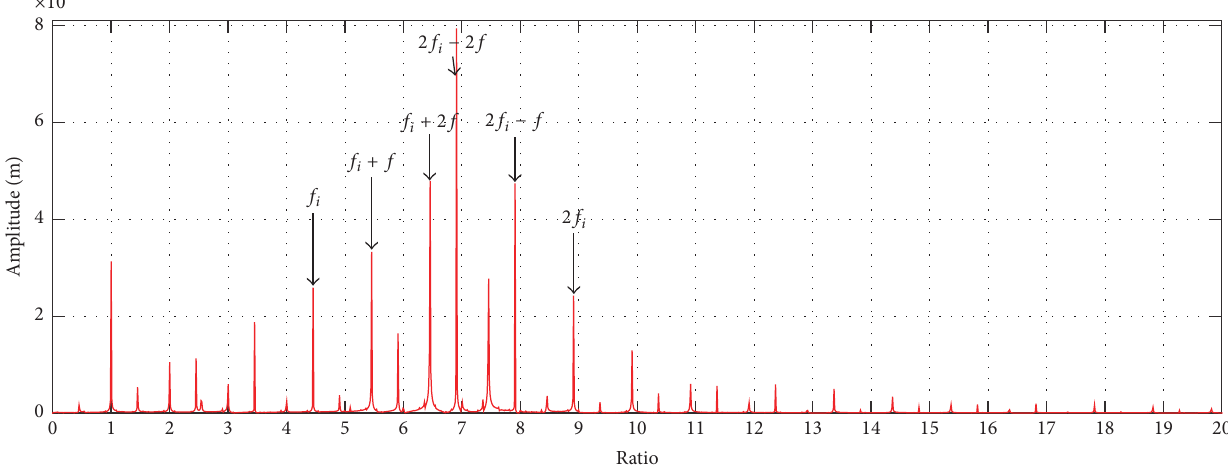
Figure 9: The spectral diagrams of the fault system with bearing inner race defect at 𝜔 = 150 rad/s and width 1𝑒 − 3 m.